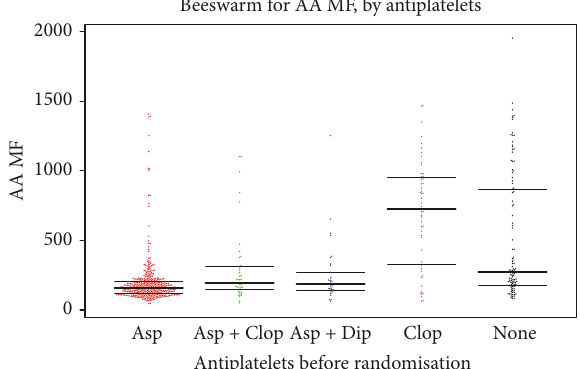
Figure 1: P-selectin in response to arachidonic acid (AA, aspirin test), by antiplatelet medication taken prior to randomisation. Data are median fluorescence (MF). The horizontal lines show the median and interquartile values.